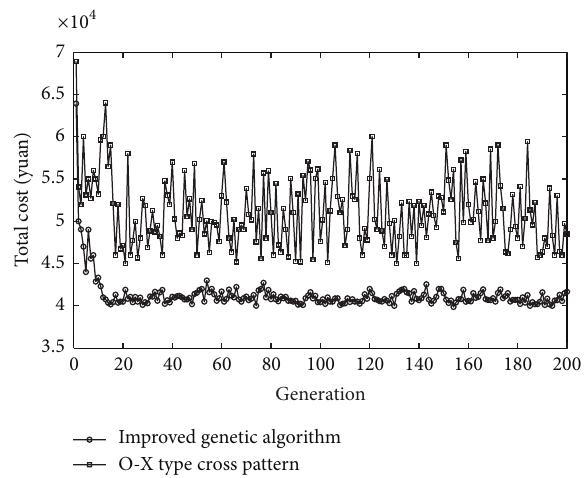
Figure 5: Population mean change contrasts of O-X type cross